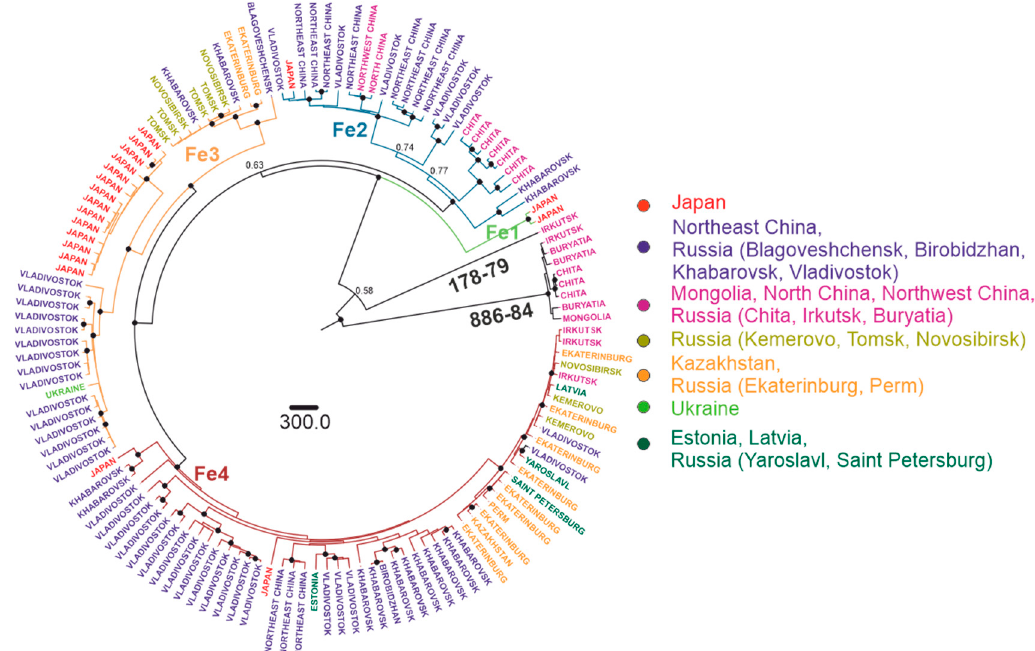
Figure 6. Bayesian phylogenetic analysis of near-complete E-gene sequences of Siberian TBEV. Branches are color-shaded according to described groups. Tree tips are named according to region of isolation. Countries or country regions of virus sampling were grouped into six color-coded geographical regions. Node posterior probabilities above 95% are shown by black circles at the relevant nodes.